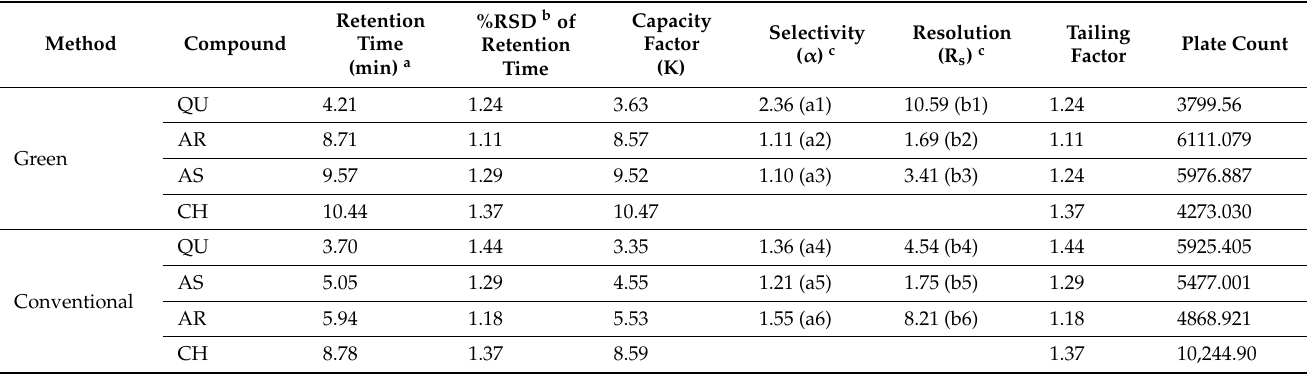
Table 1. The system suitability test results of the developed green and conventional HPLC methods for determination of QU, AS, AR, and CH.